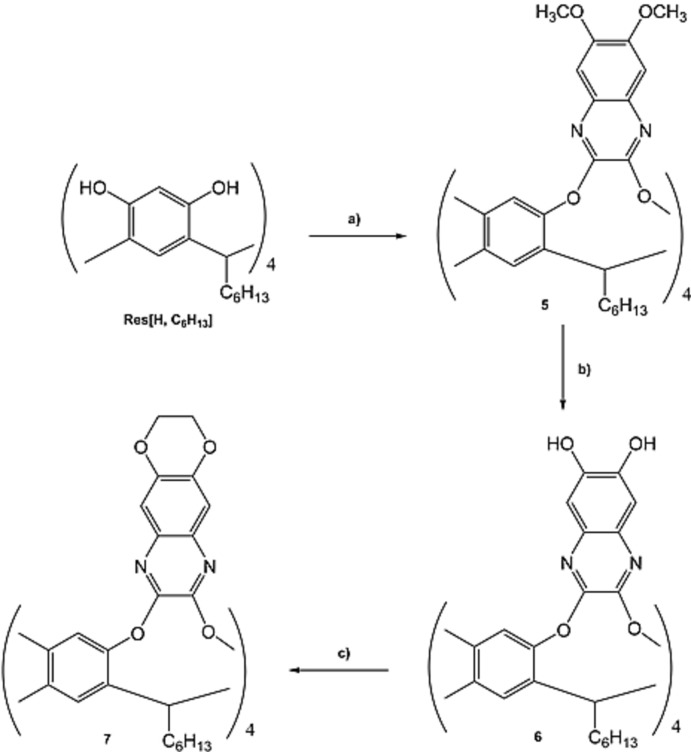
Synthesis of 7: a) 4, K2CO3, DMF, 393 K under microwave irradiation (300 W), 2 h, 92%; b) BBr3, dry chloro­form, 353 K, 24 h, 100%; c) ethyl­ene glycol di­tosyl­ate, Cs2CO3, DMF, 393 K under microwave irradiation (300 W), 1.5 h, 90%.